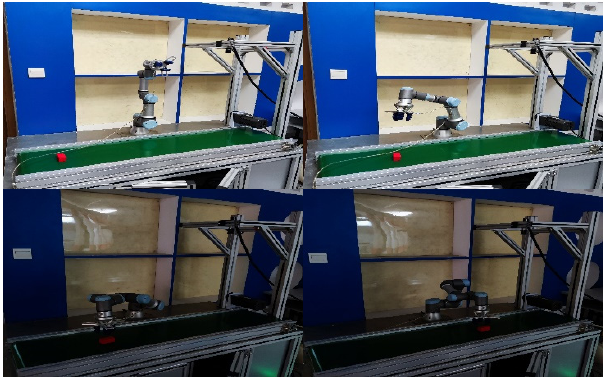
Figure 15. Experiments in low-resolution environment.